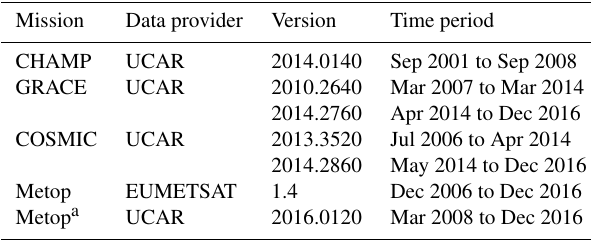
Table 1. Low-level input data to ROM SAF CDR